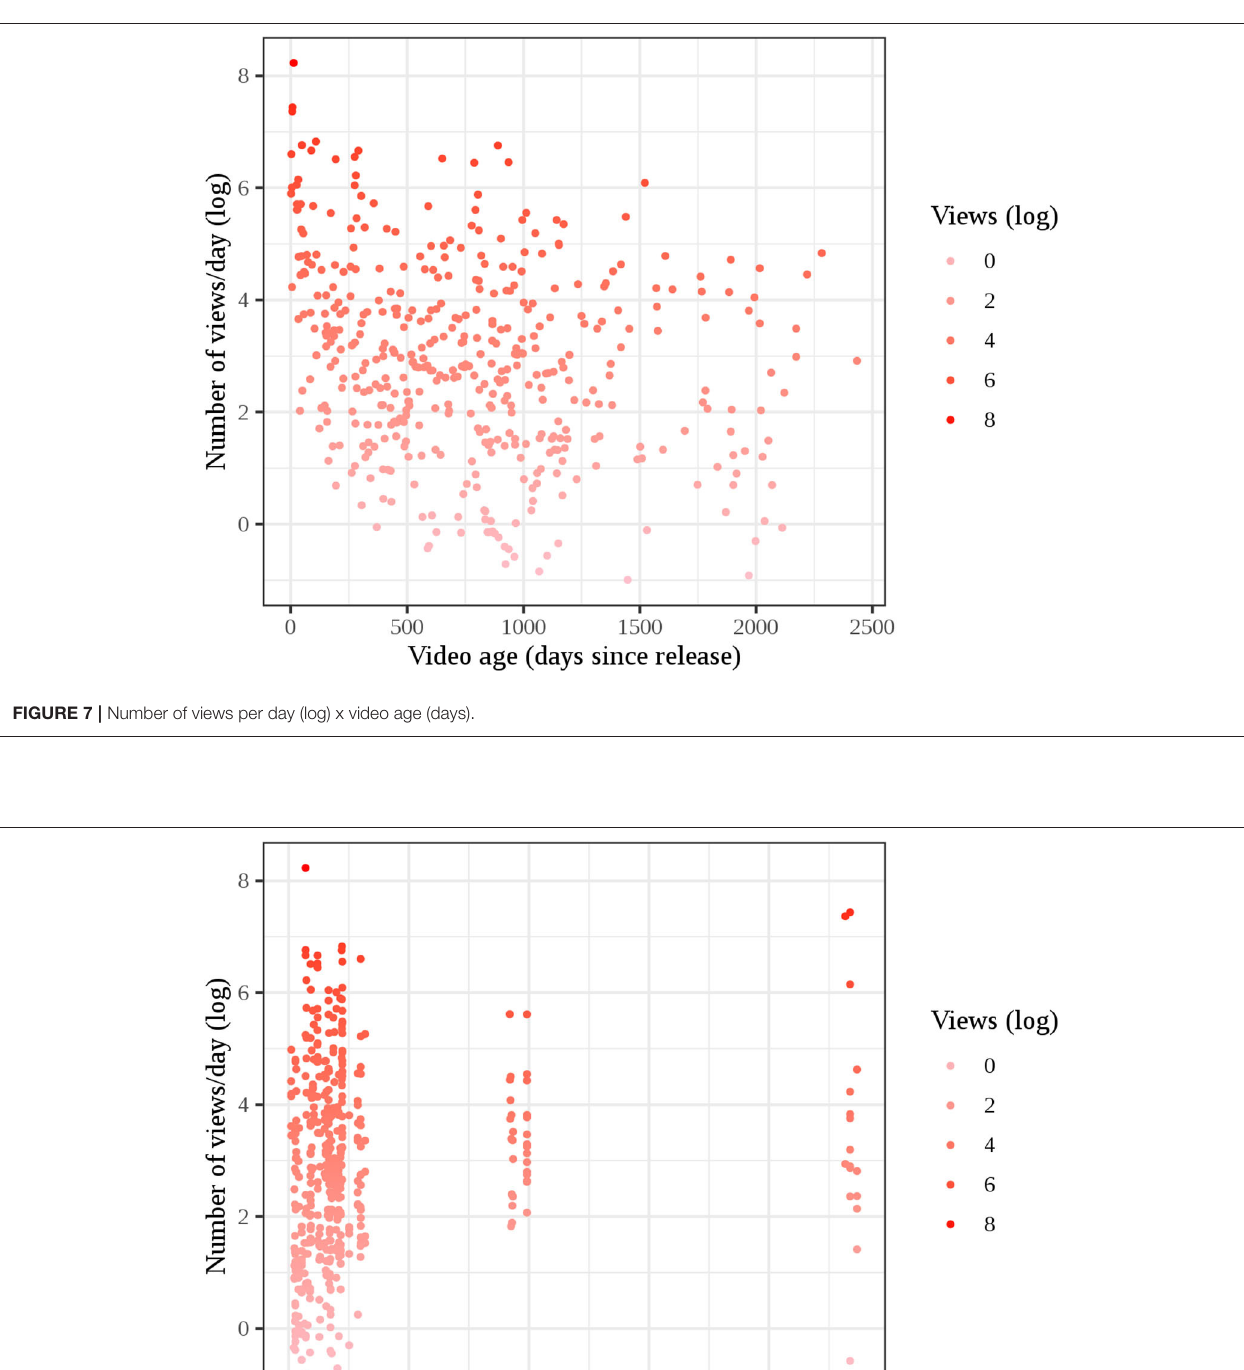
Frontiers in Communication |